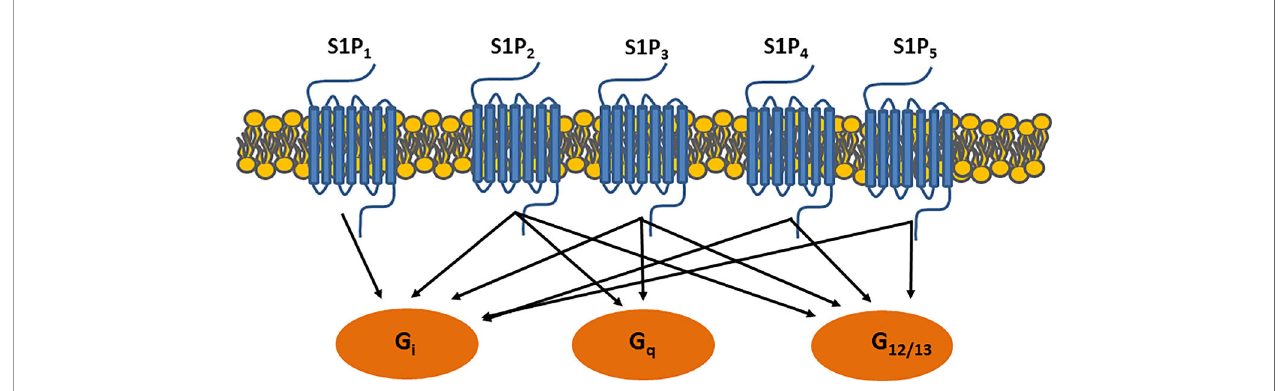
FIGURE 2 | S1P receptor signaling. Binding S1P-receptors initiates signaling through G-protein coupled receptors, which further activate small GTPase binding proteins i.e. Ras, Rac,